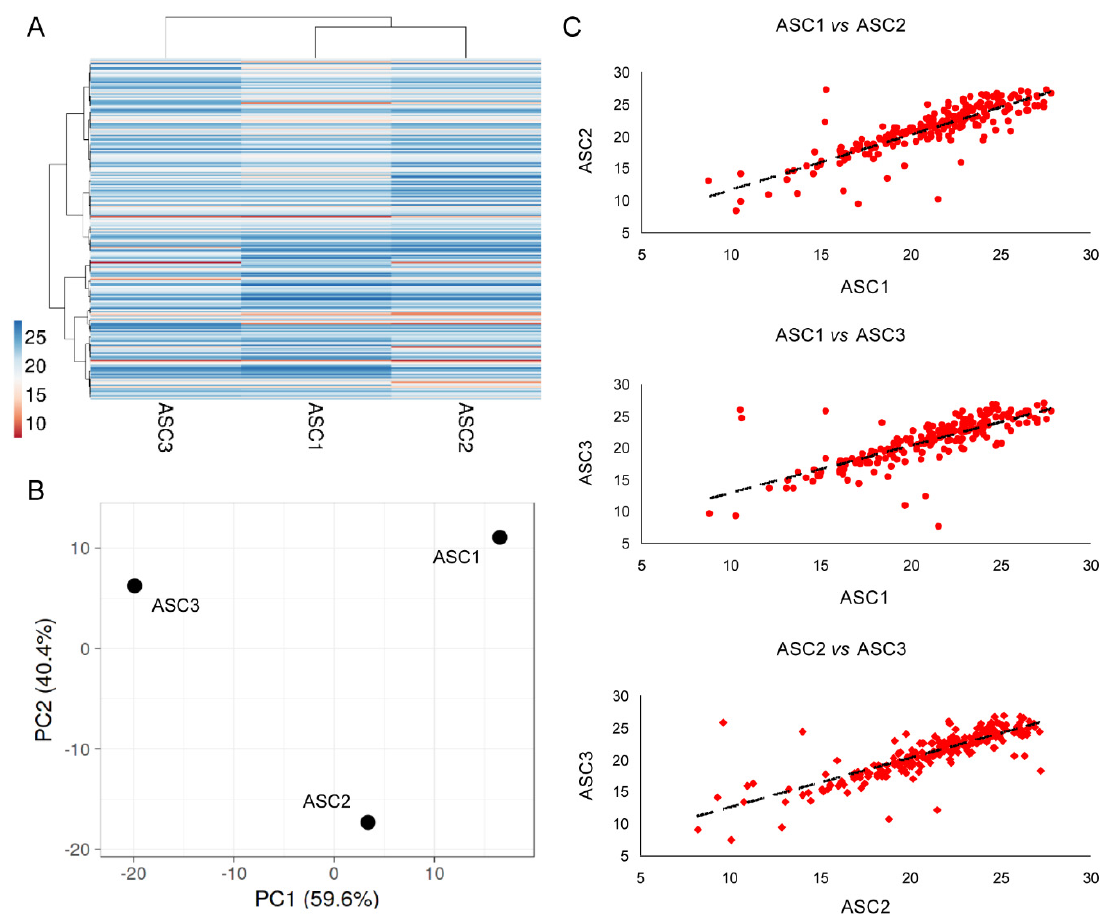
Figure 4. Comparison of EV-miRNA expression profiles between ASCs under study after OA-SF treatment. ( A ) Heat map of hierarchical clustering analysis of the normalized C RT values of detected miRNAs with sample clustering tree at the top. The color scale reflects the absolute expression levels: red shades = high expression levels (low C RT values) and blue shades = lower expression levels (high C RT values). ( B ) Principal component analysis of the normalized C RT values of detected miRNAs. X and Y axis show principal component 1 and principal component 2 that explain 59.6% and 40.4% of the total variance. ( C ) Correlation of miRNA expression levels (normalized C RT ) between the three ASC-EVs under study.